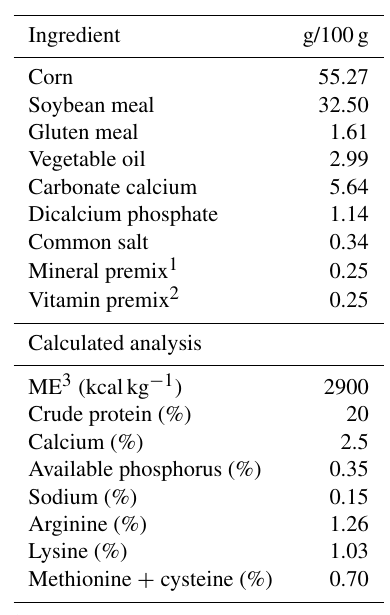
Table 1. Ingredients and chemical composition of the basal diet fed to breeder